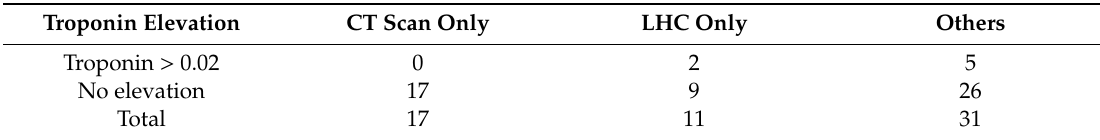
Table 6. Comparison of CT scan only vs. LHC only for diagnosis of CAD in predicting troponin elevation after pancreas transplantation. Modality of assessment did not appear to predict troponin elevation ( p = 0.20).